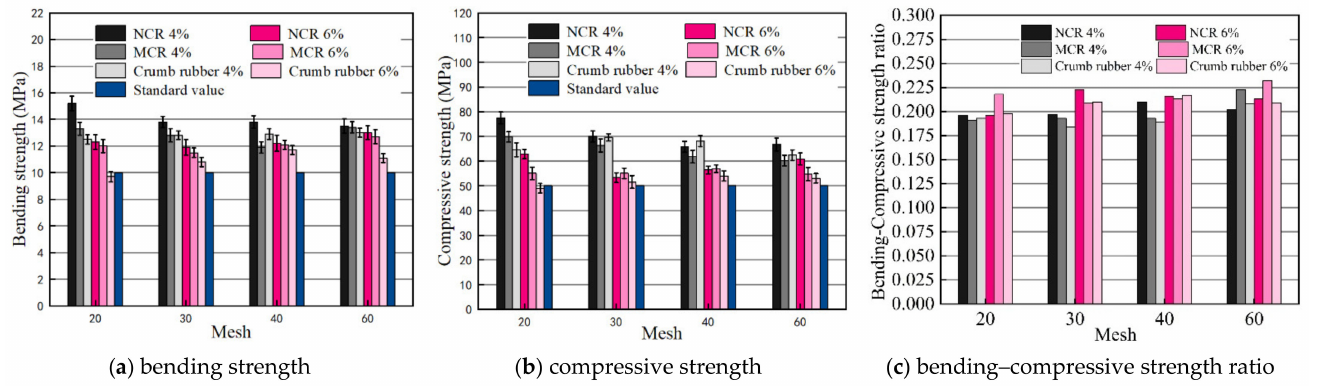
Figure 7. Mechanical strength of PPG at 28 d curing age with surface-treated crumb rubber.